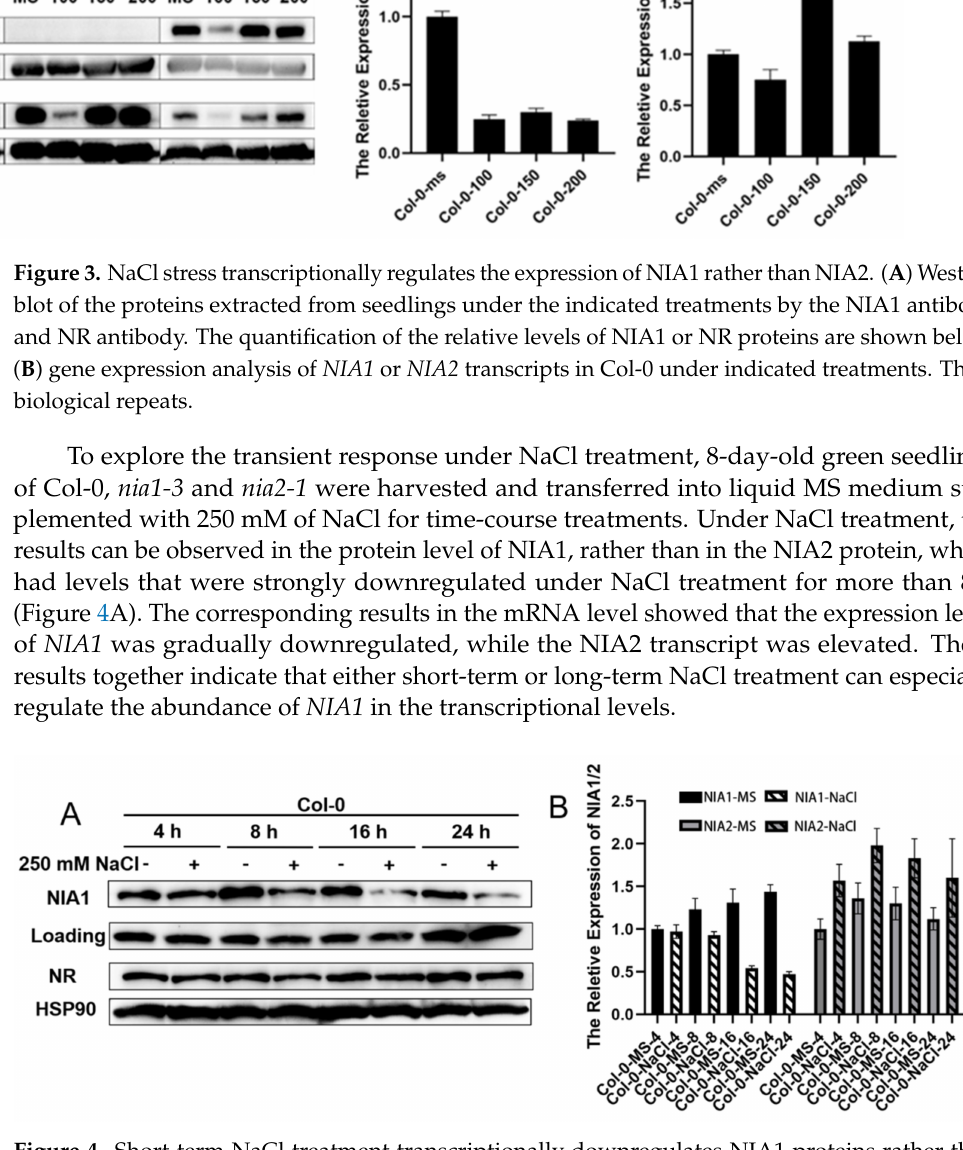
Figure 4. Short-term NaCl treatment transcriptionally downregulates NIA1 proteins rather than NIA2 proteins. ( A ) Western blot of the proteins extracted from seedlings under indicated treatments by the NIA1 antibody and NRs antibody. The quantification of the relative levels of NIA1 or NR proteins are shown below; ( B ) gene expression analysis of NIA1 or NIA2 transcripts in Col-0 under the indicated treatments. Three biological